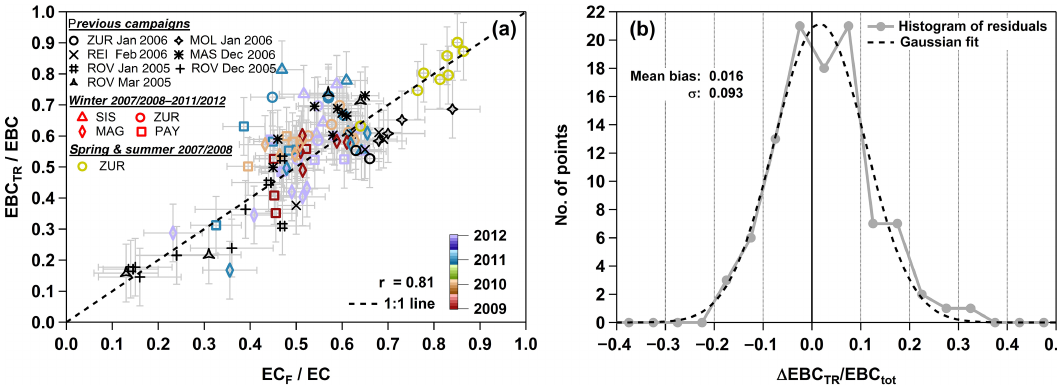
Figure 3. (a) Comparison between EBC TR / EBC at 950nm and EC F / EC and (b) residuals of EBC TR / EBC compared to EC F / EC ( (cid:49) EBC TR / EBC). EBC TR / EBC was calculated using b abs , 470 , b abs , 950 , MAC TR / MAC WB = 1, and the α values ( α WB = 1.68 and α TR = 0.90) obtained by fitting Eq. (13) against EC F / EC. The error bars for EC F / EC represent the combined uncertainty of the 14 C mea- surement of EC, the extrapolation of f M , EC to 100% EC yield, and the bomb peak correction (see Sect. 2.3). The error bars for EBC TR / EBC denote the standard deviation ( σ) of the Gaussian fit of (cid:49) EBC TR / EBC as obtained in Fig. 3b.